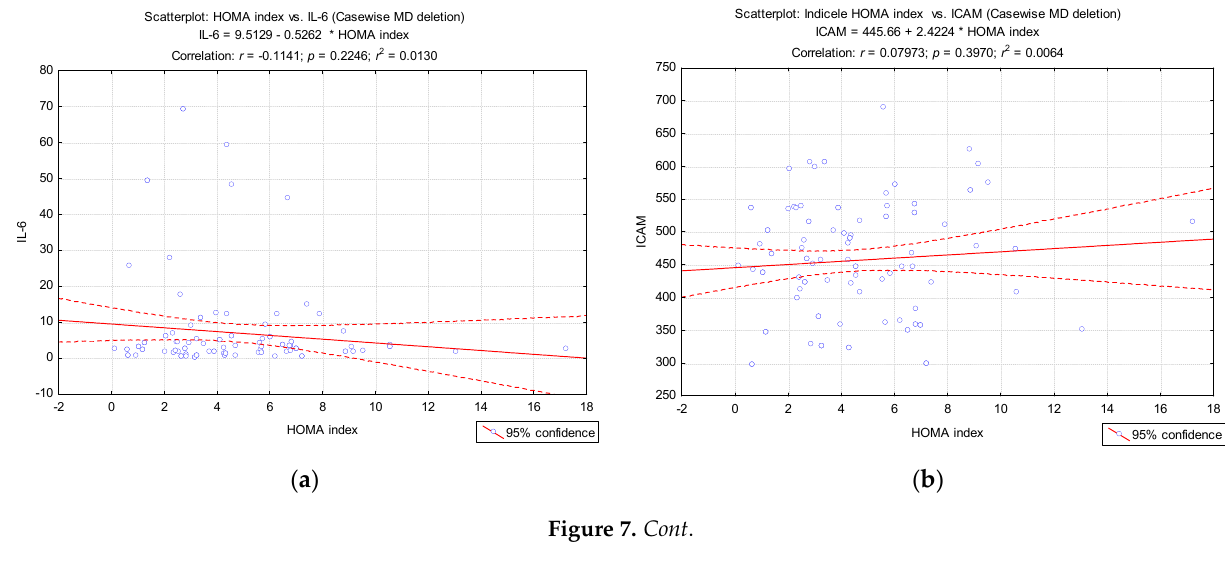
Scatterplot: Indicele HOMA index vs. ICAM (Casewise MD deletion)